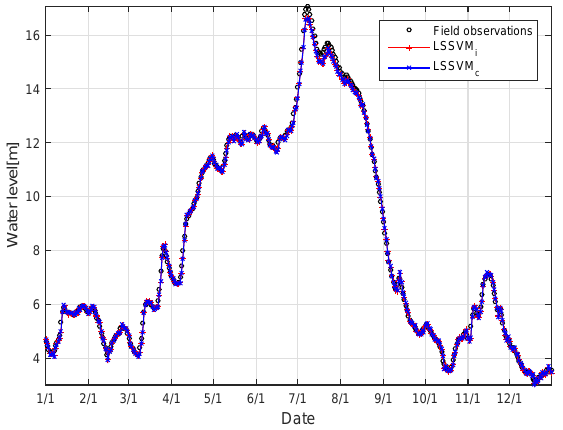
Figure 5 . Comparison between model predictions and field observations at Chenglingji (Year 2016).